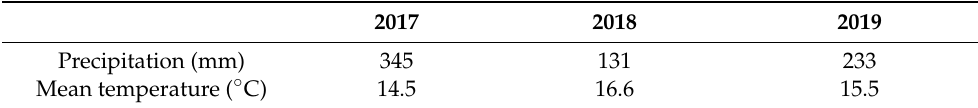
Table 2. Environmental conditions (precipitation (mm)), mean temperature ( ◦ C) at the sampling sites for each experimental year from 1 April to 30 August.